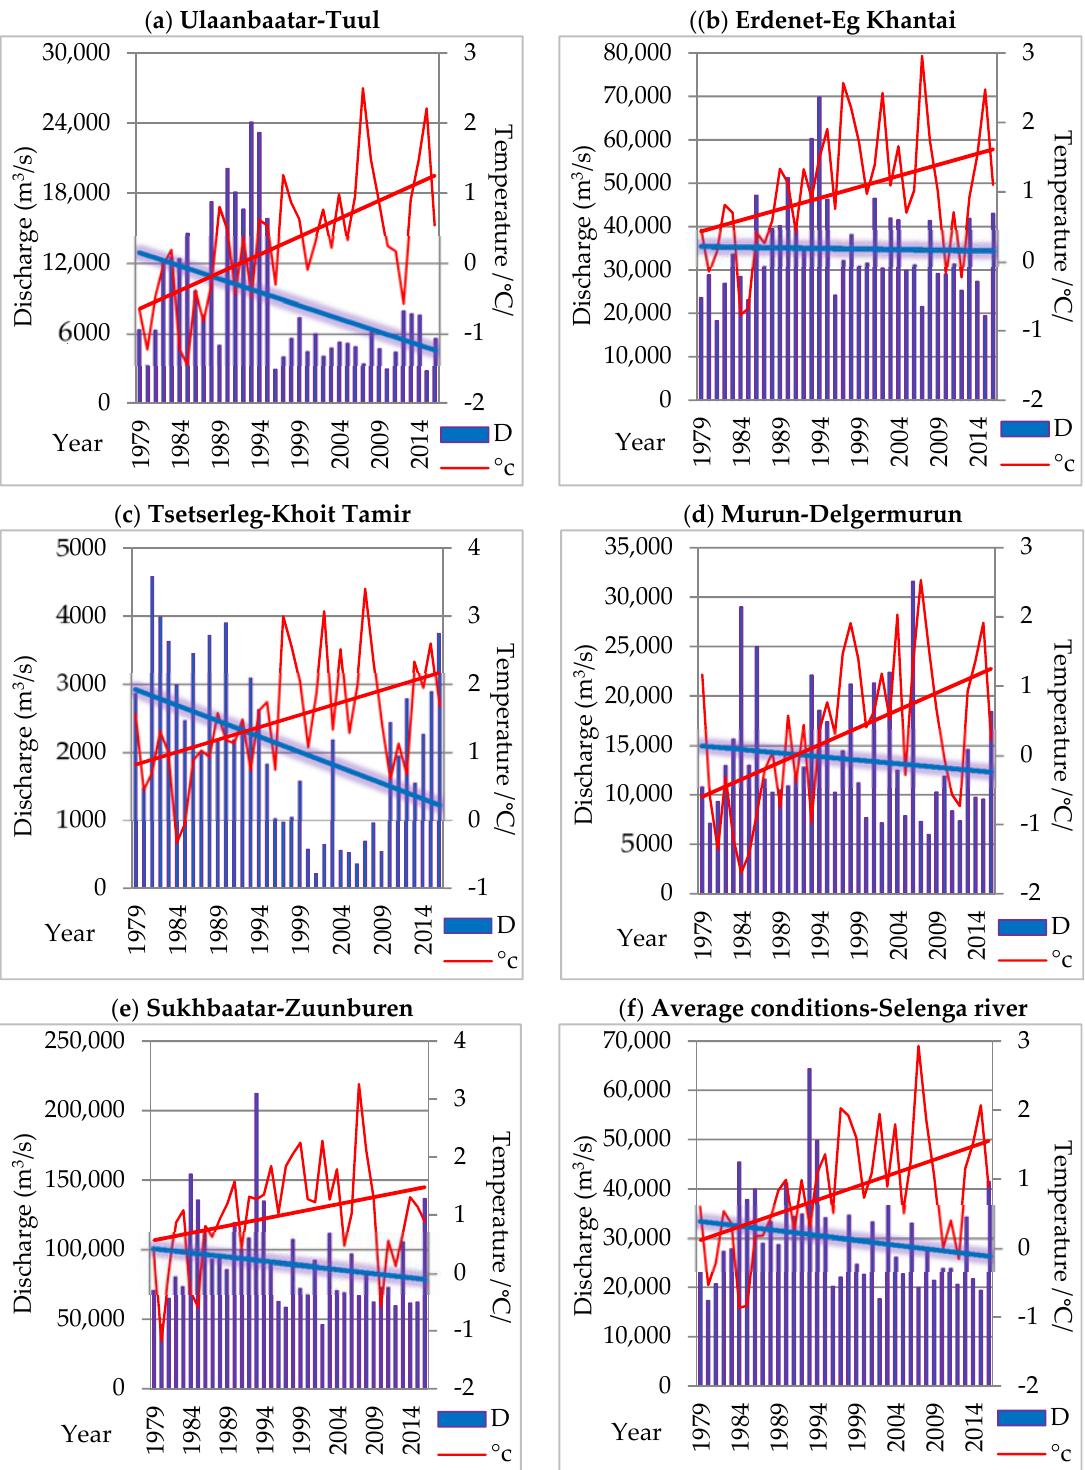
Figure 8. Long-term in air temperature and discharge change, in during 1979–2016. Potential linkages between climate variables and the observed changes in river discharge are the subject of ongoing debate. To determine this, it was the estimation of the relationship between climate parameters and river discharge (Figure 9).